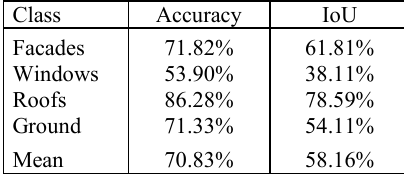
Real - word dataset. Results of image segmentation with PSP - Net.